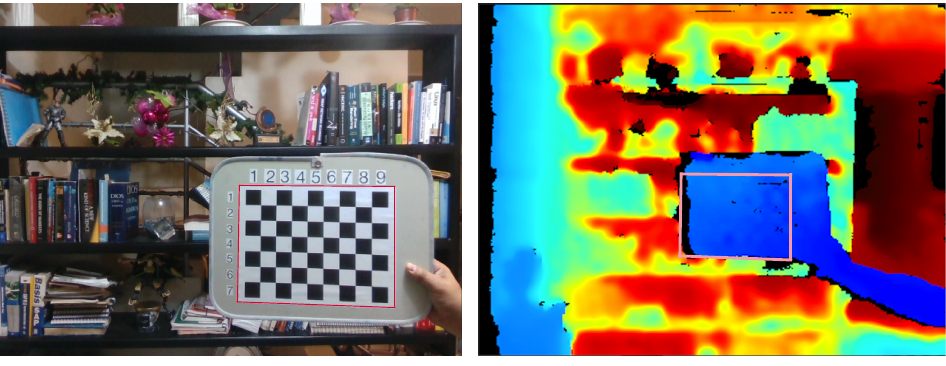
Figure 4. An alignment error example is visible in the above figure. At the left, there is a chessboard which perimeter corresponds to the red square at the right when overlapping textures in the depth image. In the right, in the depth data, chessboard corners do not correspond to the chessboard